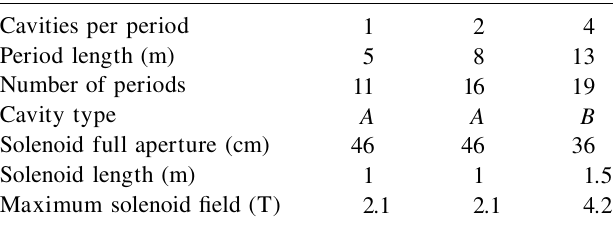
TABLE IX. Parameters for three types of linac cryomodules.